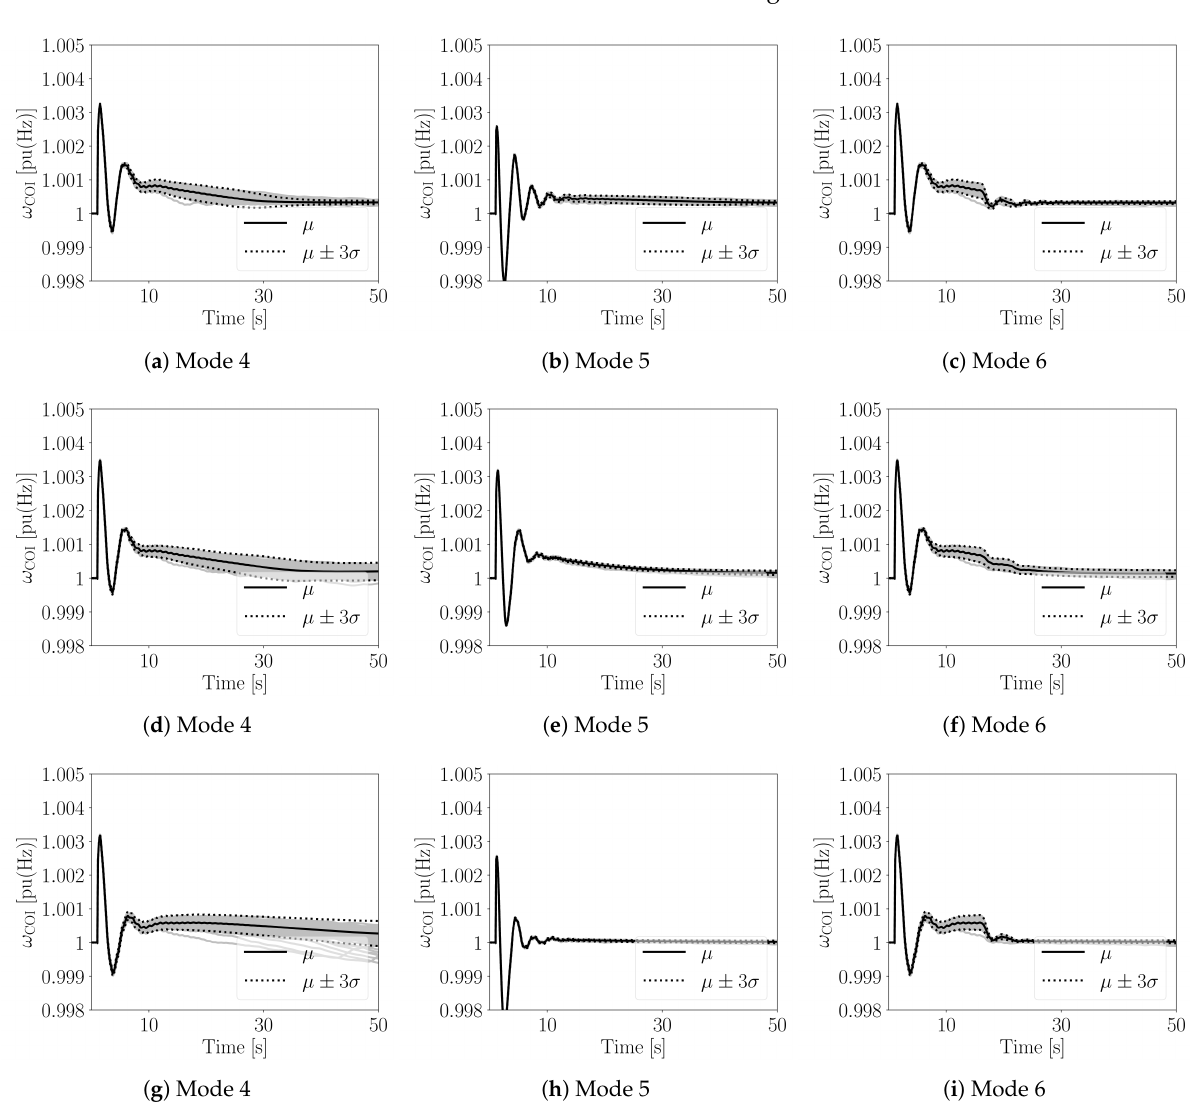
Figure 8. Trajectories of the frequency of the COI using: ( a – c ) proportional gain; ( d – f ) lead-lag controller; and ( g – i ) PI